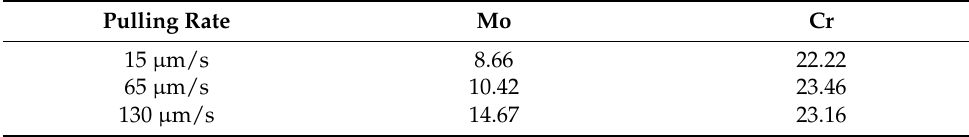
Table 4. Average Mo and Cr element content in the second phase wt%. Pulling